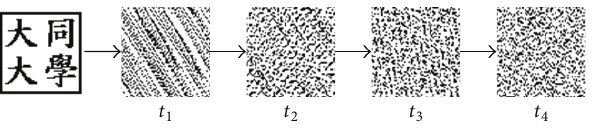
Figure 5: Example of scrambling.